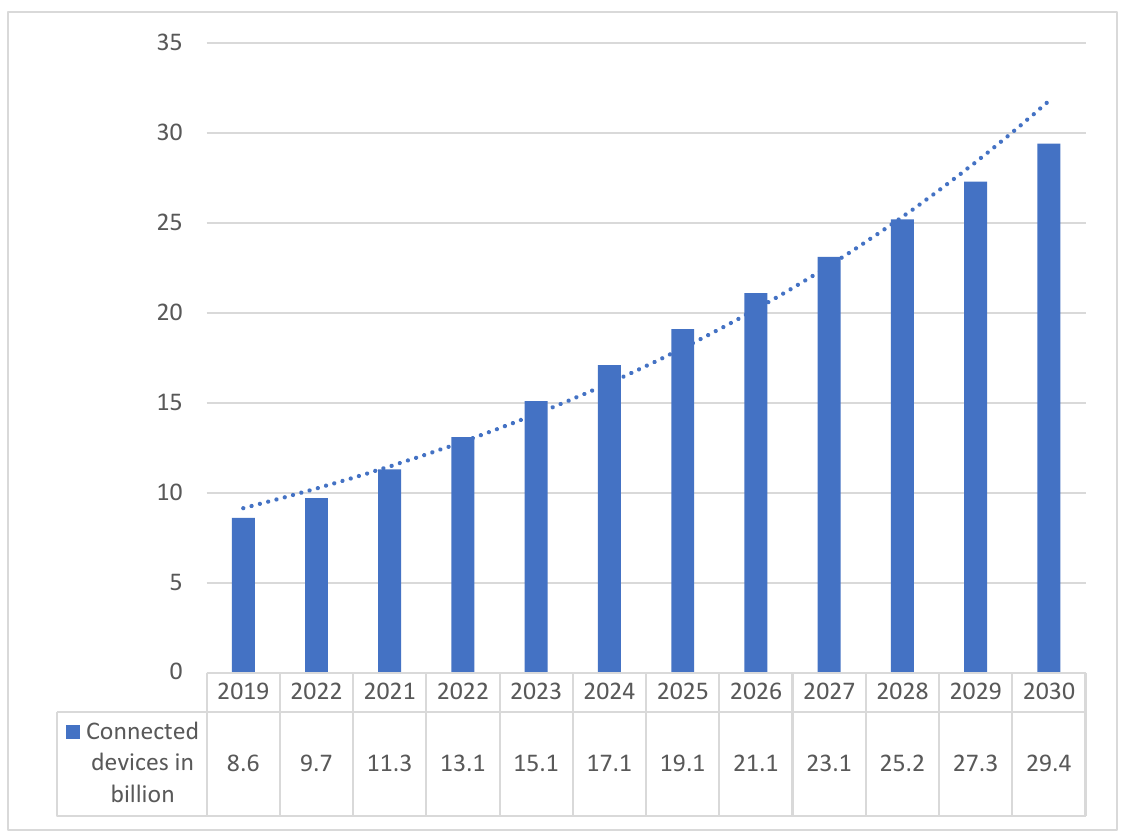
Figure 1. Number of globally connected IoT devices [8] .